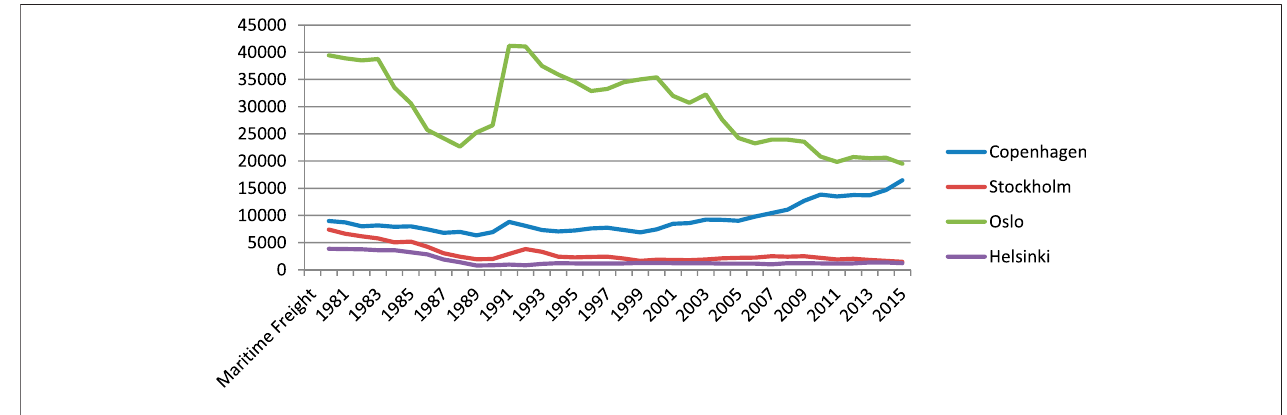
FIGURE 4 | Sea transportation of Scandinavian cities (1980 –